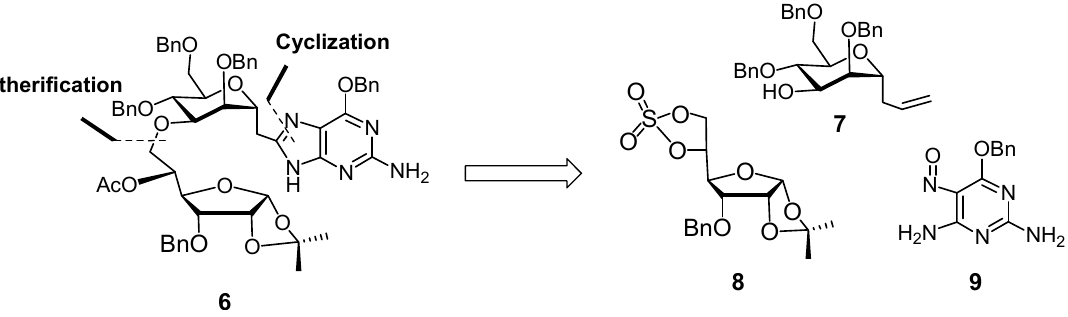
Scheme 1. Retrosynthesis of pseudodisaccharide-guanine hybrid 6